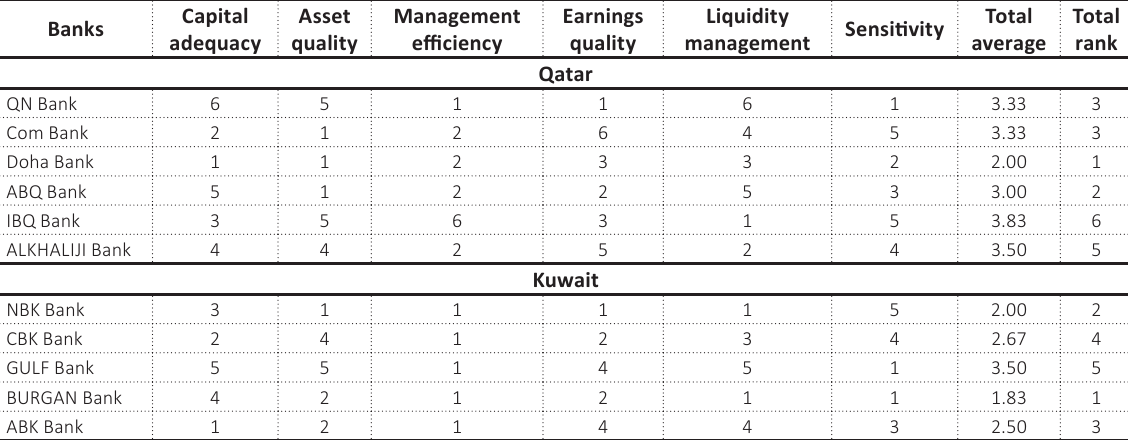
Table 9. The overall ranking of the selected banks from Qatar and Kuwait for the period